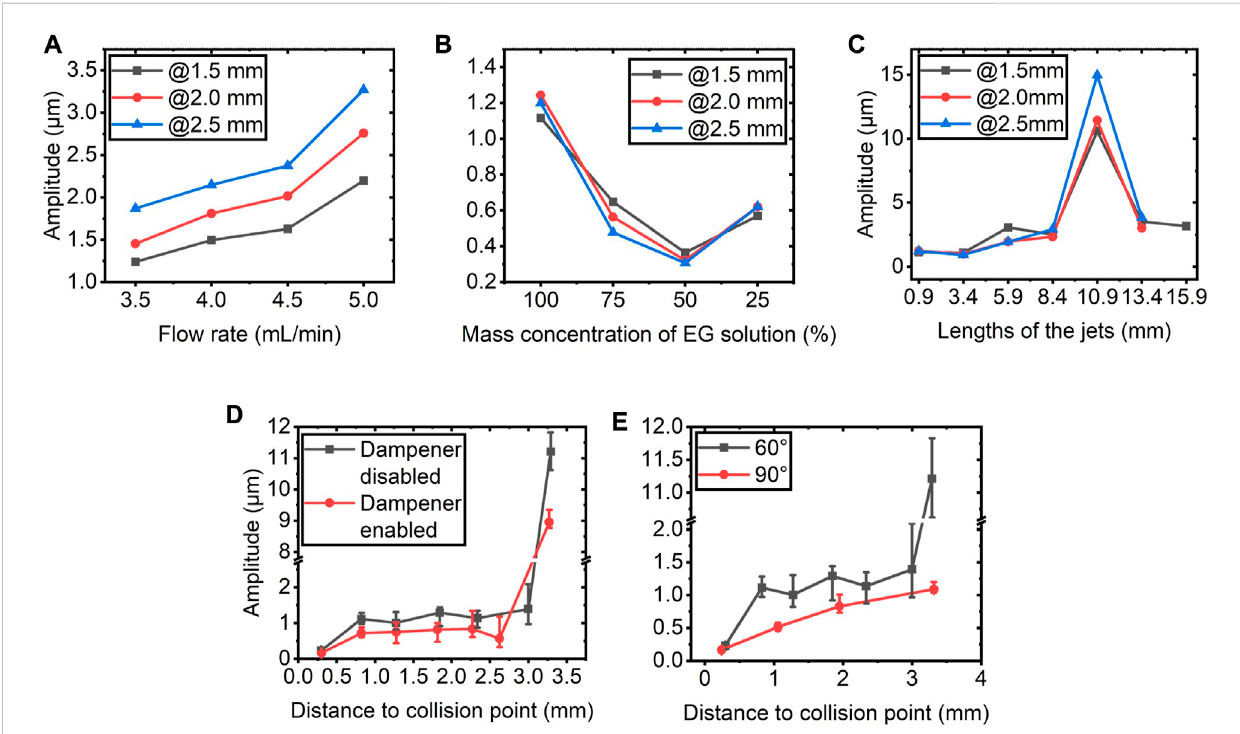
FIGURE 5 Motion amplitude of liquid sheets with different generation parameters: (A) fl ow rate, (B) mass concentration of, EG solution, (C) lengths of the jets, (D) status of pulsation dampener, (E) collision angle (2 θ